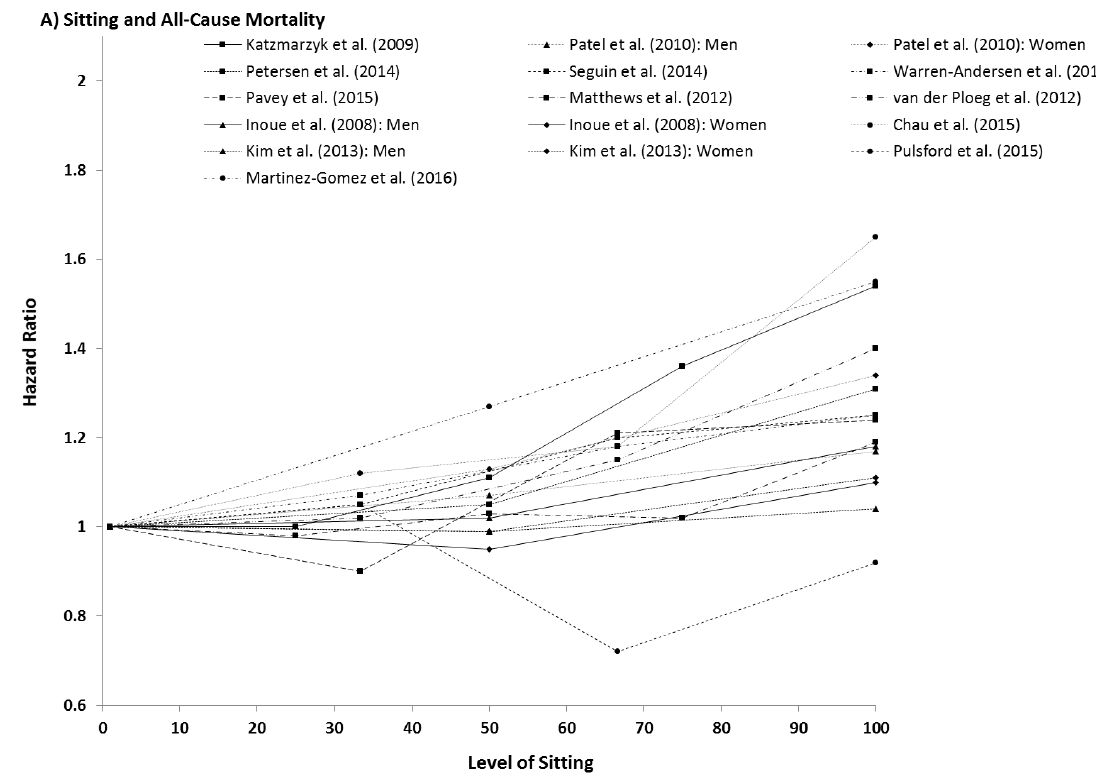
Figure F2-1. Dose-Response Curves Showing Relationship Between Sedentary Behavior and All-Cause